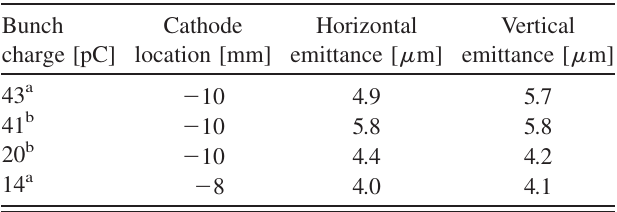
a Beam energy measured with dipole. b Beam energy estimated from measurement of transmitted power.